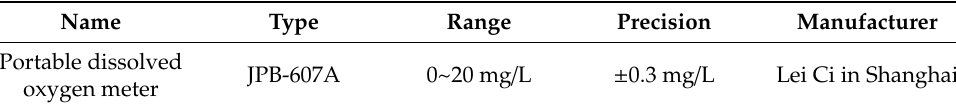
Table 1. Detailed description of the portable dissolved oxygen meter.